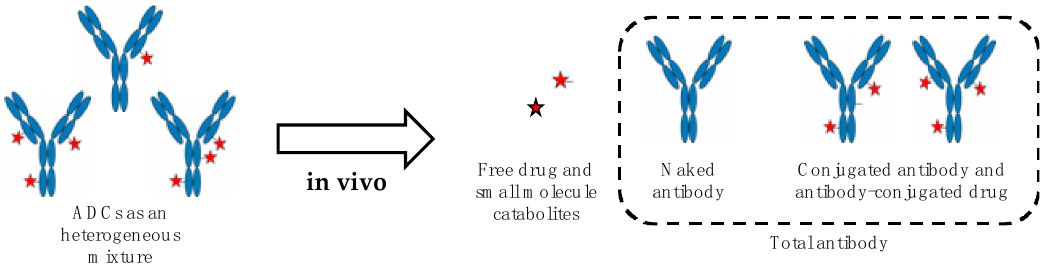
Figure 1. The catabolic fate of ADCs increases the complexity of the mixture in vivo giving rise to multiple analytes to be measured. The antibody is colored in blue, the free drug and its metabolites are represented as red stars.